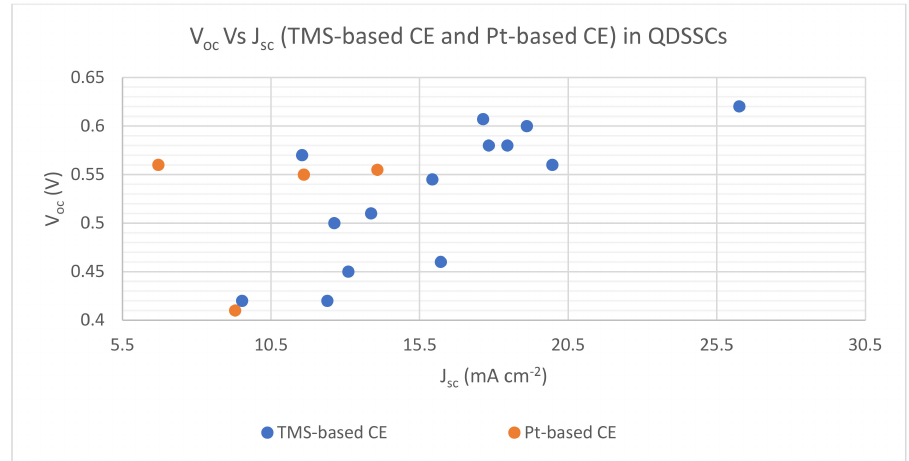
Figure 13. The V oc Vs J sc for TMS-based CE and Pt-based CE in